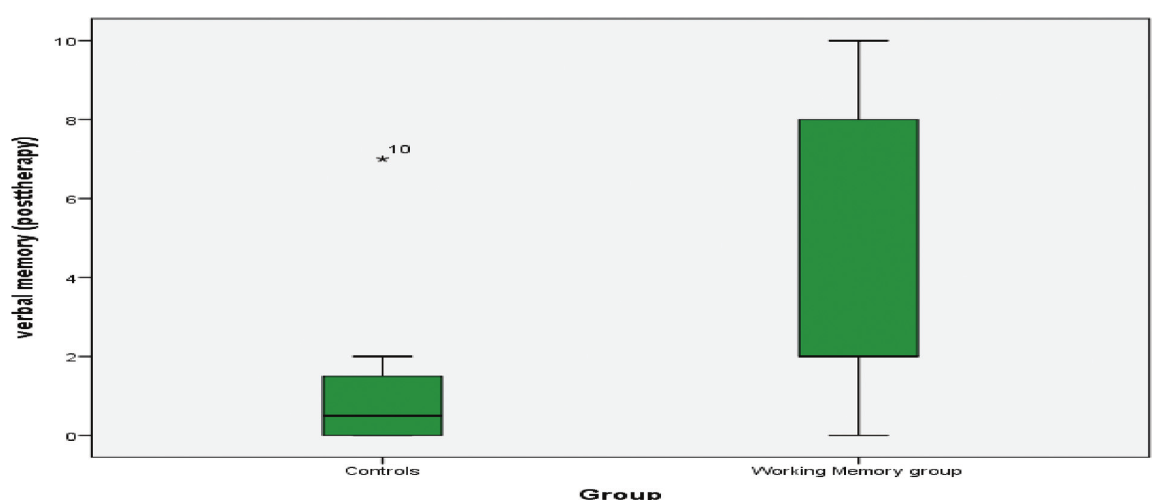
Comparison between two groups in verbal memory post-therapy results.